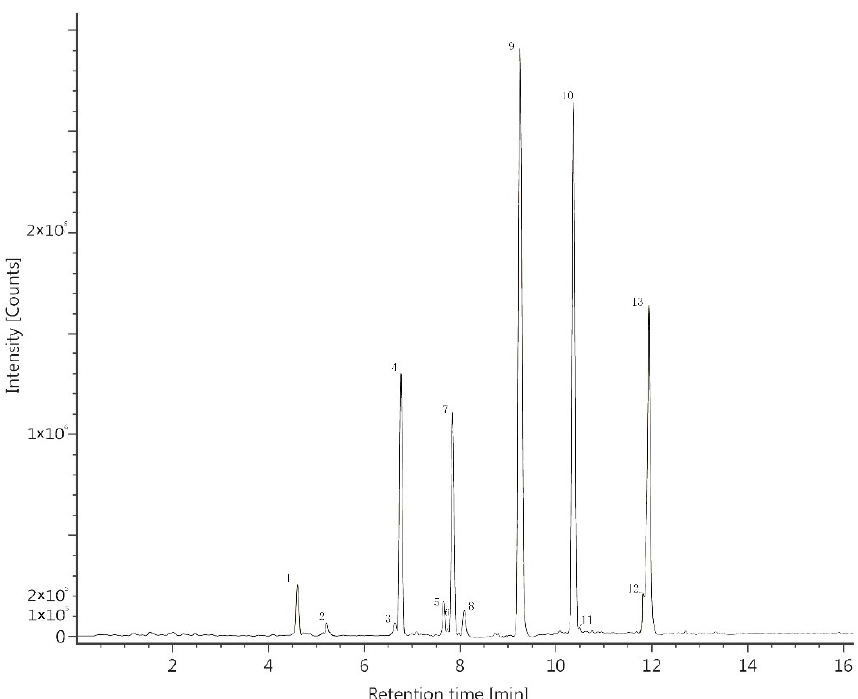
Figure 1. UPLC-MS chromatogram of polyphenolics in T. ramosissima crude extract infusion: quercetin 3-O-glucuronide (1), kaempferol 3-O-glucuronide (2), eriodictyol (3), quercetin (4), naringenin (5), tangeretin (6), kaempferol (7), hesperetin (8), isorhamnetin (9), hispidulin (10), apigenin (11), glycitein (12), cirsimaritin (13). Table 3. Concentrations of four representative polyphenolic standards.